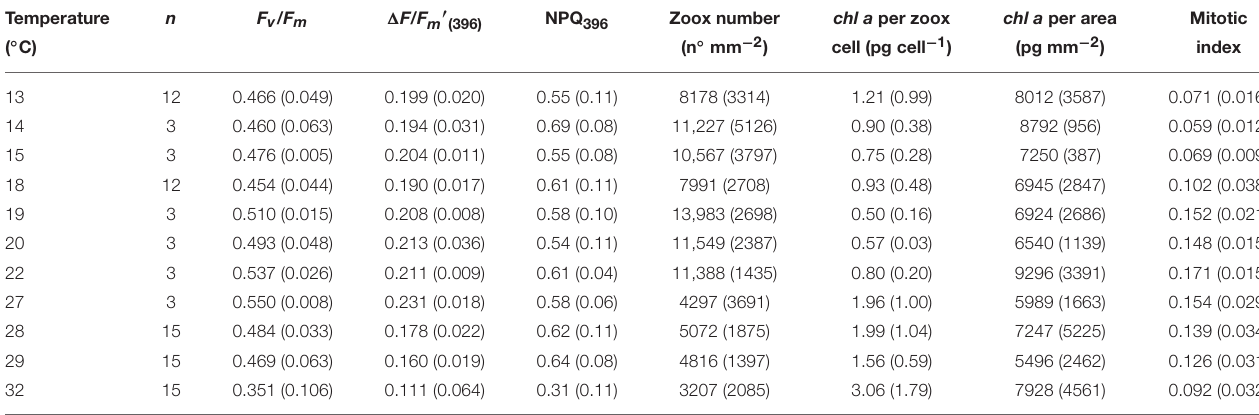
TABLE 2 | Number of analyzed corals (n), mean F v / F m , 1 F/F m ′ (396) , NPQ 396 , number of zooxanthellae per area, chl a content per zooxanthellae cell, chl a content per area, and mitotic index for each temperature. Temperature